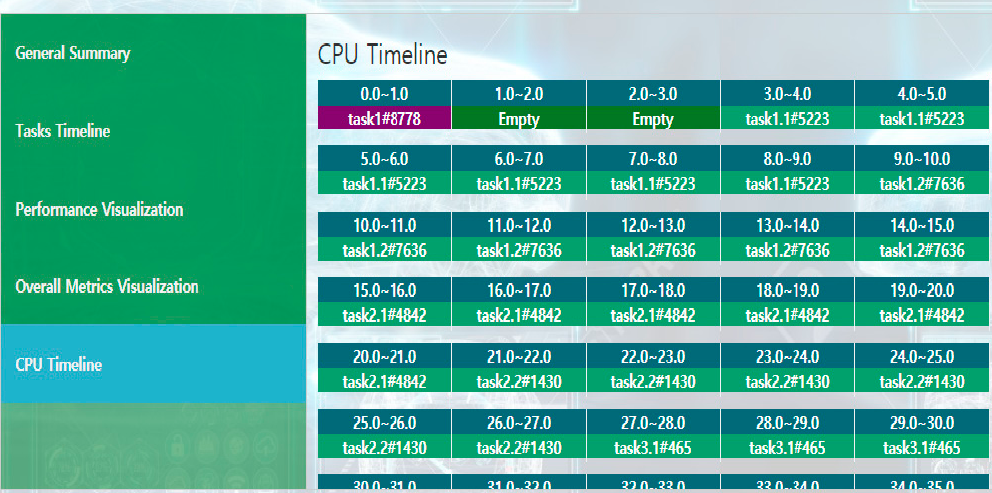
Table 8. Input data scenarios. Scenarios